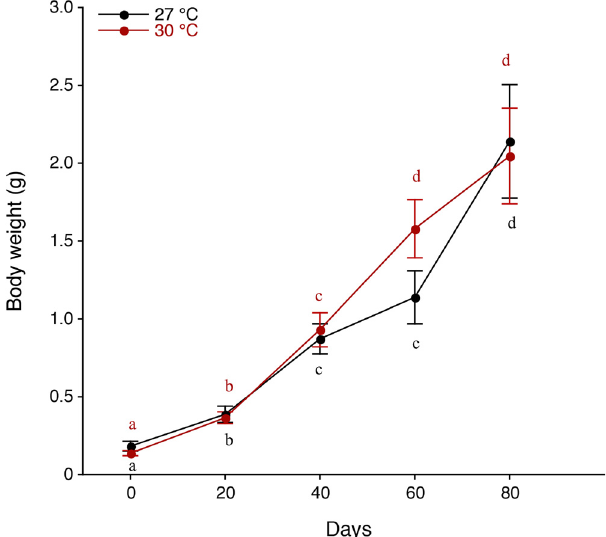
Figure 4: Growth patterns of body weight of postlarvae in the giant freshwater prawn Macrobrachium rosenbergii reared in di ff erent temperature regimes of 27°C ( black ) and 30°C ( red ) . The results are expressed as the mean ± standard error ( SE ) . The letters a, b, c, and d indicate a statistically signi fi cant di ff erence at p < 0.05 between each experimental period in di ff erent temperature regimes of 27°C ( black ) and 30°C ( red ) .